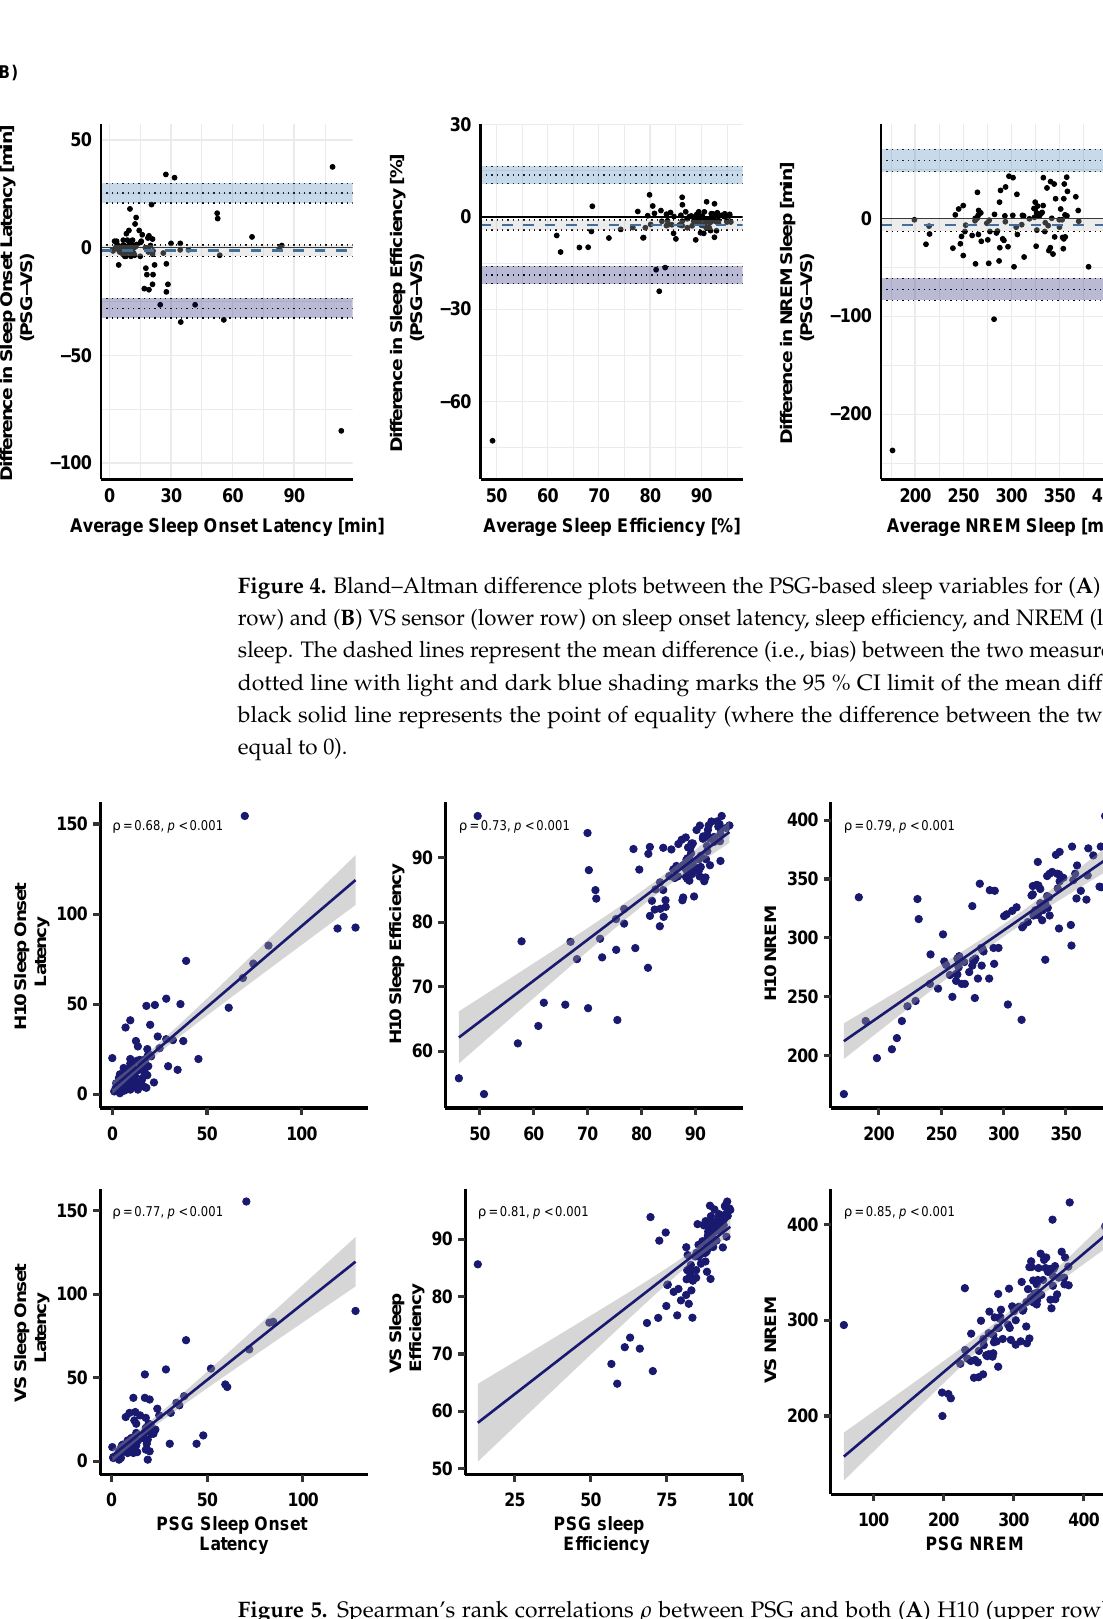
Figure 5. Spearman’s rank correlations ρ between PSG and both ( A ) H10 (upper row), as well as ( B ) VS (lower row) on sleep onset latency, sleep efficiency, and NREM (light + deep) sleep. Individual points reflect sleep parameters as extracted from each device, with the corresponding liner model (line) and 95% confidence interval (shade). Note the slightly higher correlation coefficients for the VS compared to